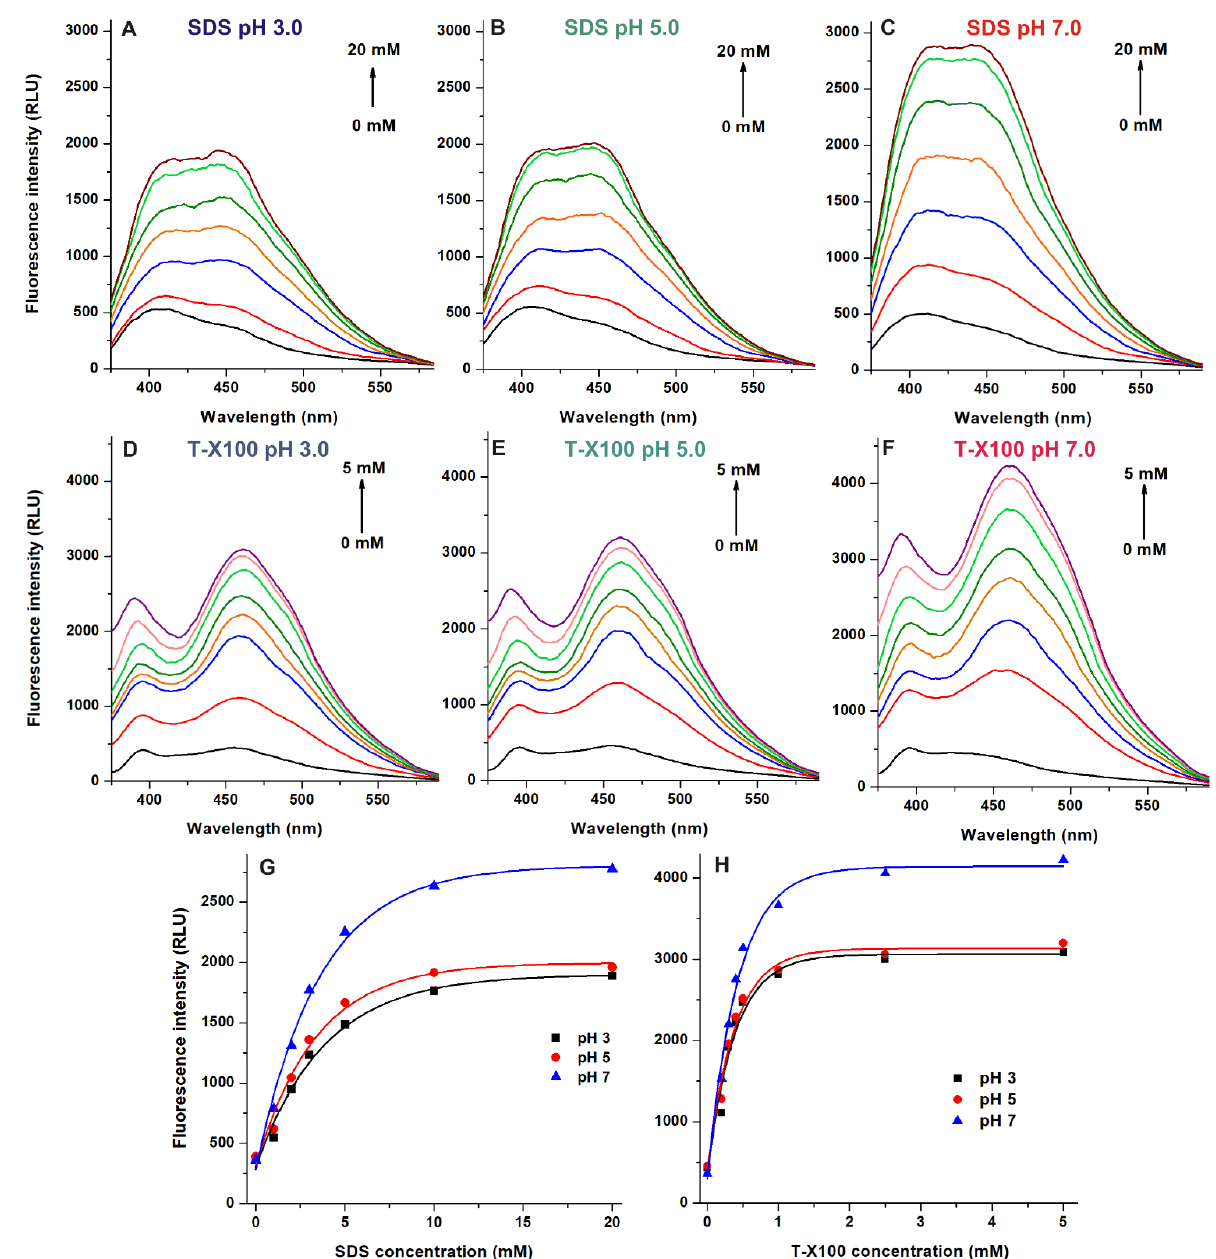
Figure 4. Fluorescence emission spectra of AOH (5 μ M) in the presence of increasing concentrations of sodium dodecyl- sulfate (SDS; pH 3.0 ( A ), pH 5.0 ( B ), and pH 7.0 ( C ) and Triton-X100 (T-X100); pH 3.0 ( D ), pH 5.0 ( E ), and pH 7.0 ( F ). SDS- ( G ) and T-X100-induced ( H ) increase in the emission signal of AOH ( λ ex = 345 nm, λ em = 460 nm; ex and em slits: 10 nm; buffers used: 50 mM pH 3.0 sodium phosphate, 50 mM pH 5.0 sodium acetate, and 50 mM pH 7.0 Tris-HCl; RLU: relative light unit).